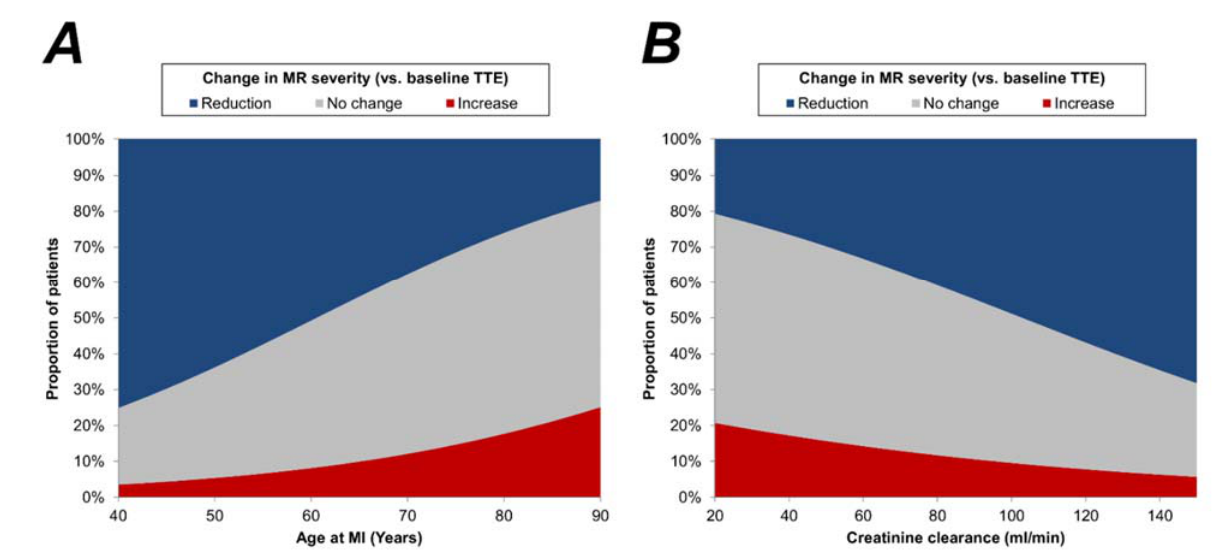
Figure 3. Associations between age/creatinine clearance and changes in MR severity. Plots are based on binary logistic regression models, with either the age (A) or creatinine clearance (B) as a continuous covariate. Two models were produced for each factor, with the dependent variable being reduction in MR severity (vs. increase or no change) in the first, and increase in MR severity (vs. reduction or no change) in the second. For all models, the changes in MR severity were assessed between the baseline and final TTE for each patient. The two models were then evaluated to estimate the rates of reductions and increases in MR severity for each value of the covariate, with the difference between these assumed to be the rate of “no change”. MI = myocardial infarction; MR = mitral regurgitation; TTE = transthoracic echocardiography.